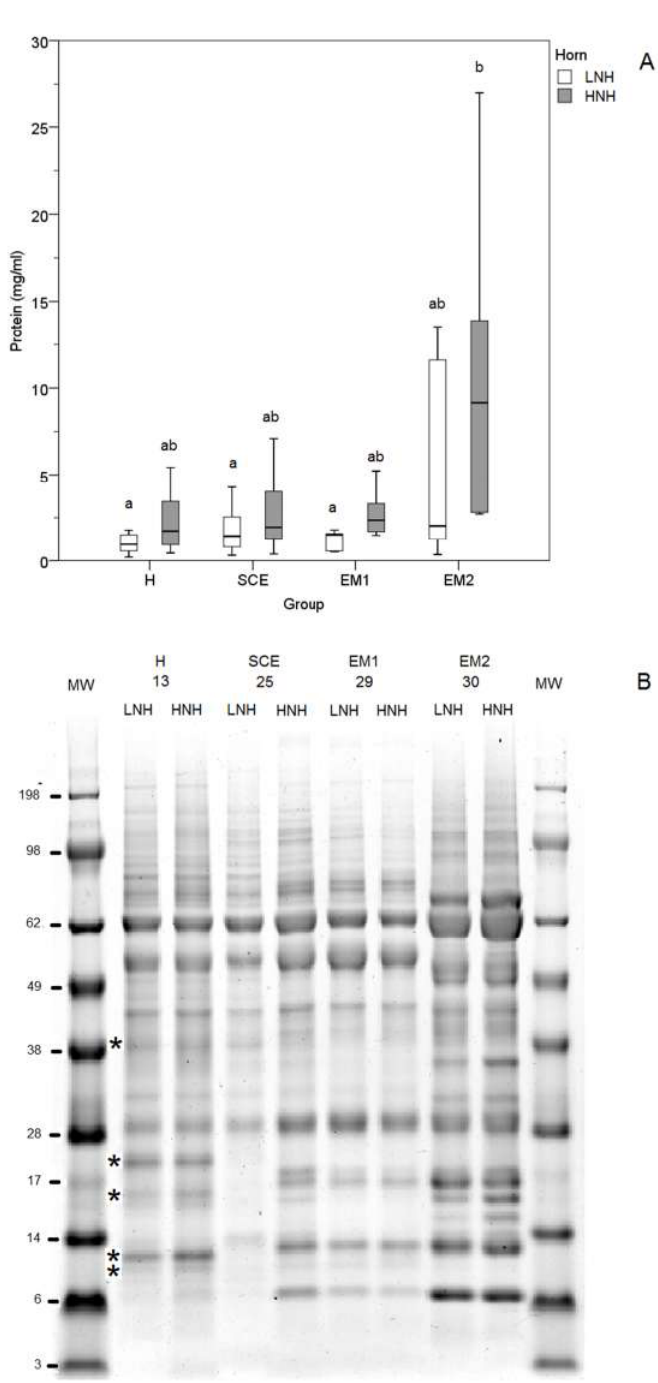
Figure 3. Concentrations ( A ) and SDS-PAG electrophoresis ( B ) of the proteins in the uterine horn lavage (UHL) fluids obtained from the uterine horns with the higher and lower neutrophil percentage (HNH) and (LNH), respectively ( A ). MW: molecular weights; H (Healthy cows): Clinically healthy subjects with PMN < 5%, one week after the clinical evaluation; SCE (Subclinical Endometritis): Clinically healthy subjects and PMN ≥ 5%, one week after the clinical evaluation; EM1 (Grade 1 Endometritis): Animals with grade 1 clinical endometritis and PMN ≥ 5%, one week after the clinical evaluation; EM2 (Grade 2 Endometritis): Animals with grade 2 clinical endometritis and PMN ≥ 5%, one week after the clinical evaluation. Different superscripts (a, b) indicate a statistically significant different group ( p < 0.05; Kruskal-Wallis one-way ANOVA and multiple comparisons, SPSS 24.0). The asterisks indicates electrophoretic bands exclusively present in the H cows.